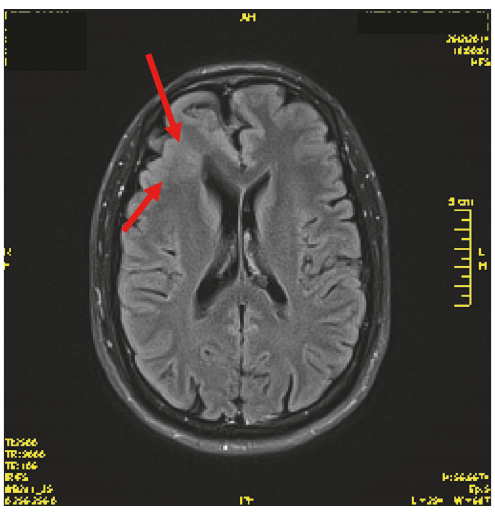
Figure 1: MRI-FLAIR sequence.